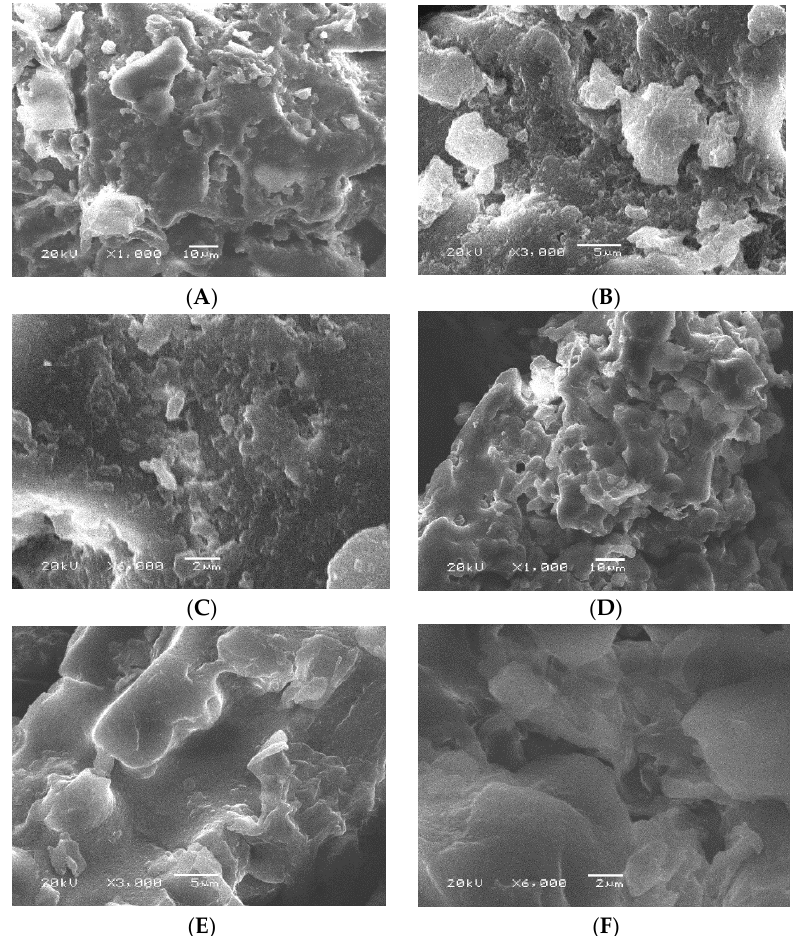
Figure 2. SEM images of ADP ( A – C ) and TADP ( D – F ) at various magnification: 1000x and 10 µm; 3000x and 5 µm: and 6000x magnification with 2 µm diameter.